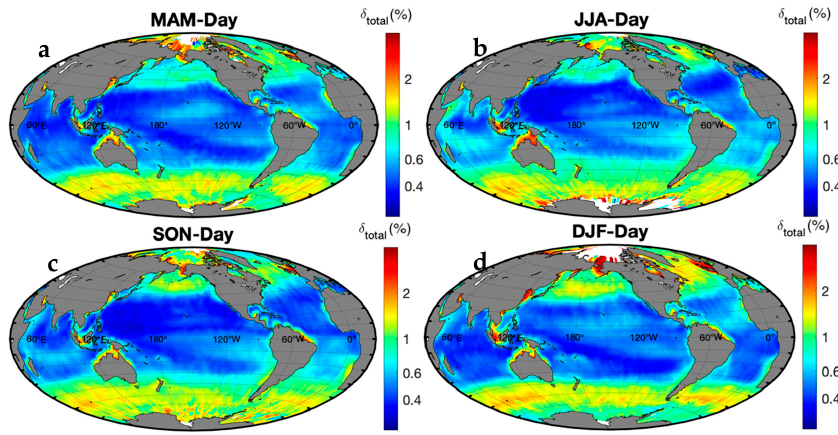
crosstalk correction. ( a ) March–May; ( b ) June–August; ( c ) September–November; ( d ) December–